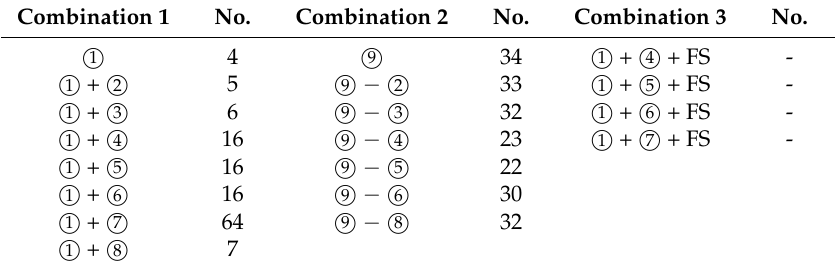
Table 2. Feature combinations used in this study: 1 (cid:13) : spectral bands; 2 (cid:13) : vegetation index; 3 (cid:13) : PC bands; 4 (cid:13) : the Gaussian low-pass filters; 5 (cid:13) : the mean filters; 6 (cid:13) : the standard deviation filters; 7 (cid:13) : texture measures; 8 (cid:13) : topographic variables; and 9 (cid:13) : feature subset. FS: feature selection procedure; -: the number was indefinite. The column titled “No.” in the caption represents the number of different variables. The sign “ − ” represents exclusion of certain feature sets from the feature